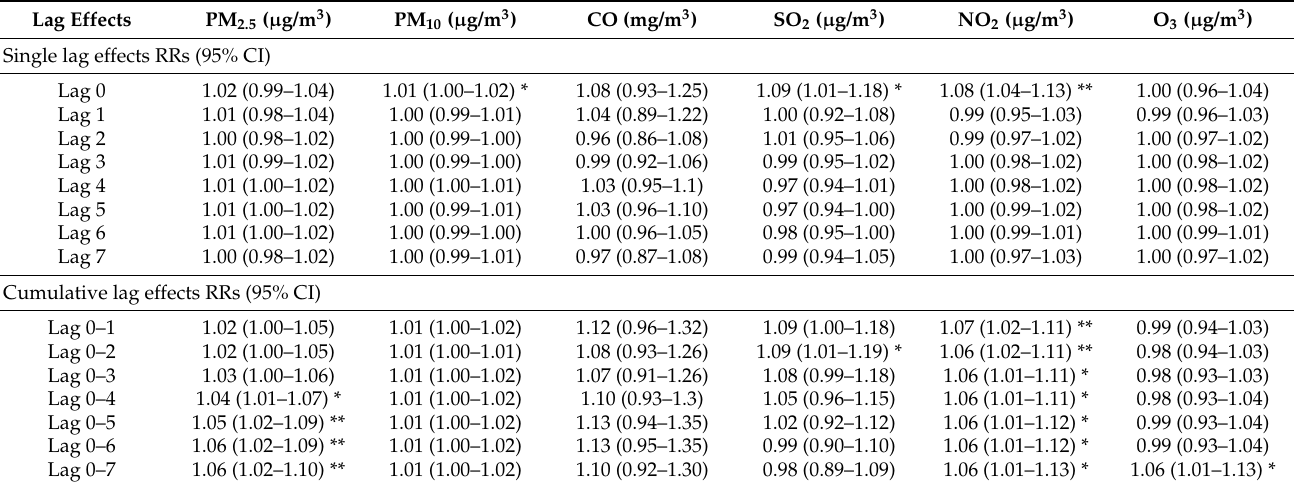
Table 2. The relative risks (RRs) of per 10 units increase in air pollutants on DED outpatient visits at various lag days: Single-pollutant model.